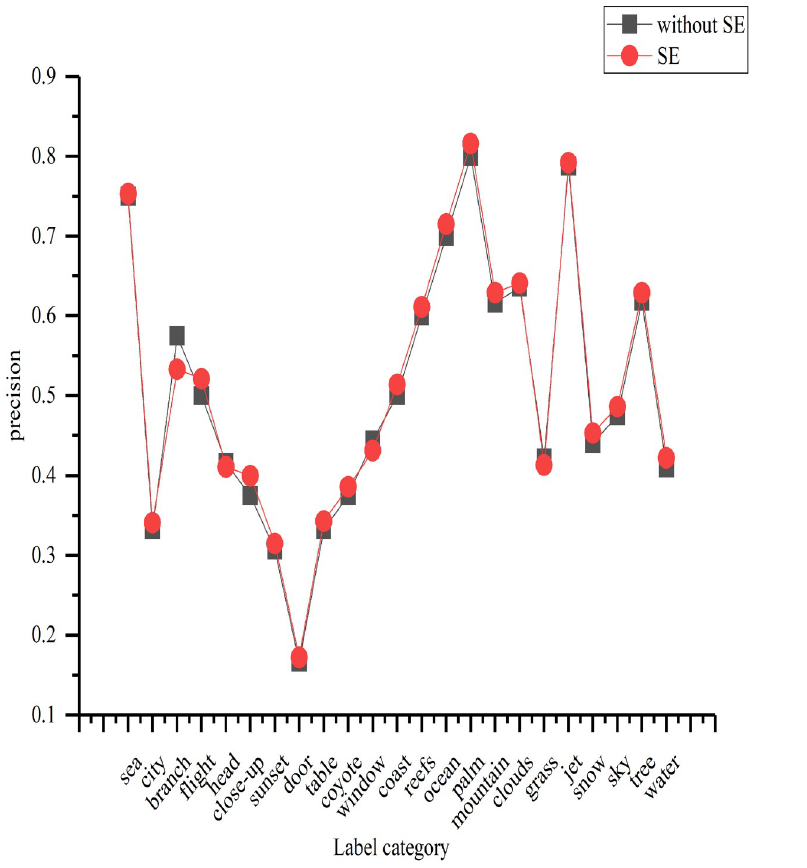
Fig 6. Comparison of the annotation performance with and without the SE